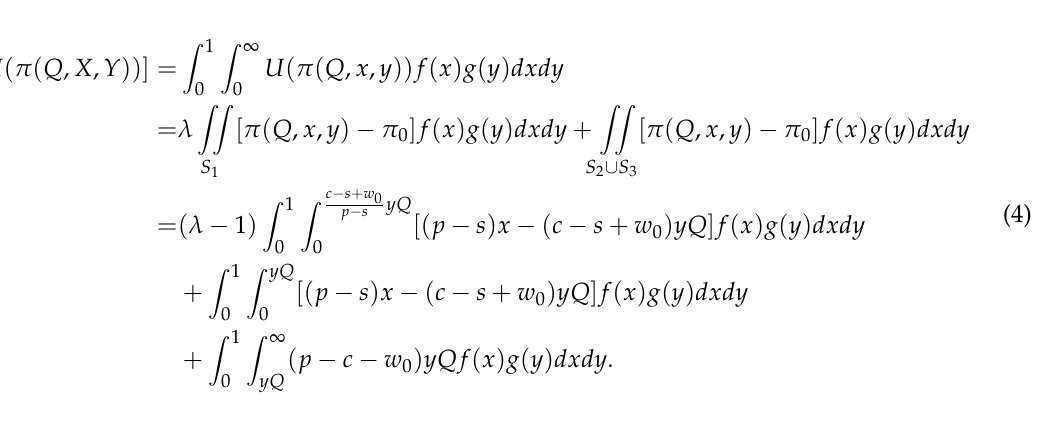
Figure 1. A graphical presentation of demand and yield rate